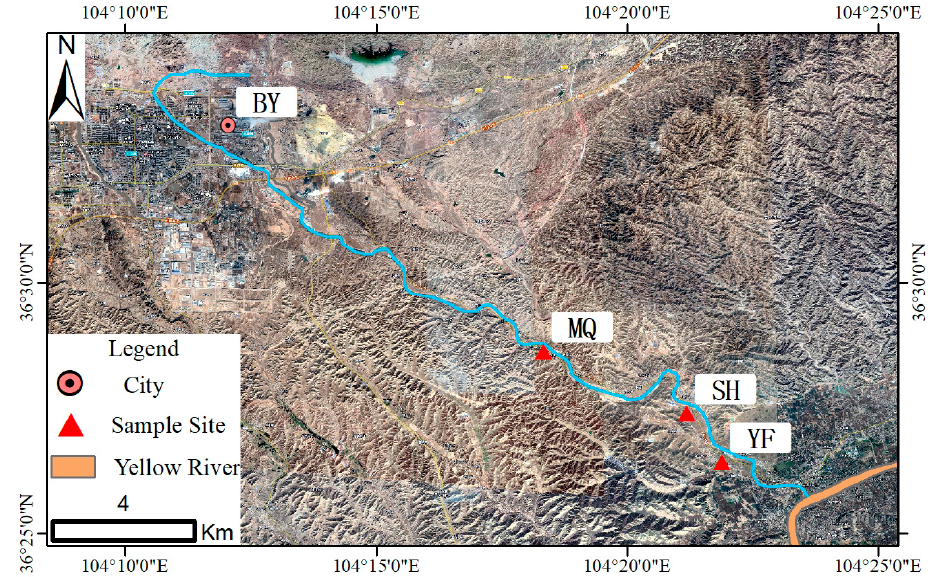
Figure 1. Map of the study area. MQ, SH, and YF represent MQ village, SH village, and YF village, respectively. BY represents BY city, which is an important metal mining and smelting base.